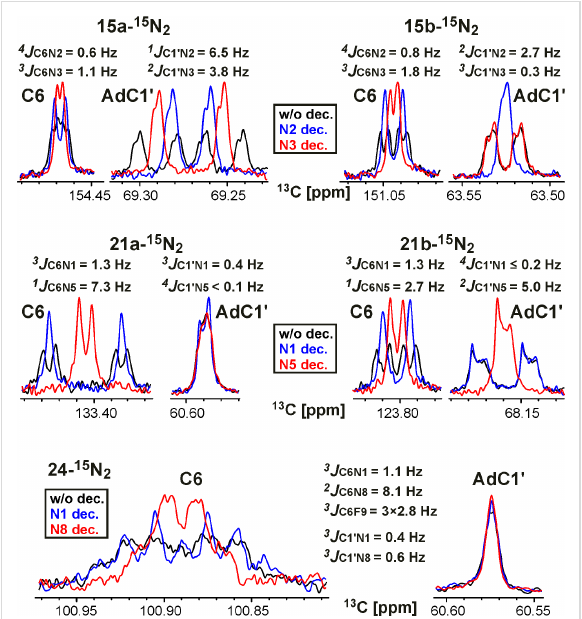
Figure 3: Signals of the C1' and C6 atoms in the proton-decoupled 1D 13 C NMR spectra of 30–42 mM 15a,b- 15 N 2 , 21a,b- 15 N 2 and 24- 15 N 2 in DMSO- d 6 (45 ºC). The spectra were measured without (black traces) and with band-selective decoupling from the 15 N1/ 15 N2 or 15 N3/ 15 N5/ 15 N8 nuclei (blue or red traces, respectively). The values of J CN obtained by line-shape analysis are listed. The additional split- tings of the C1' signals are due to the presence of two structural forms of adamantane substituents (see text for details).